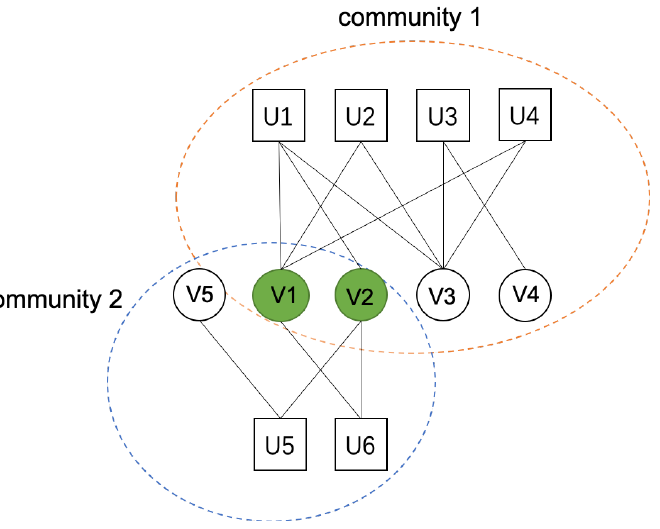
Figure 1. Bipartite network example—South Africa companies bipartite